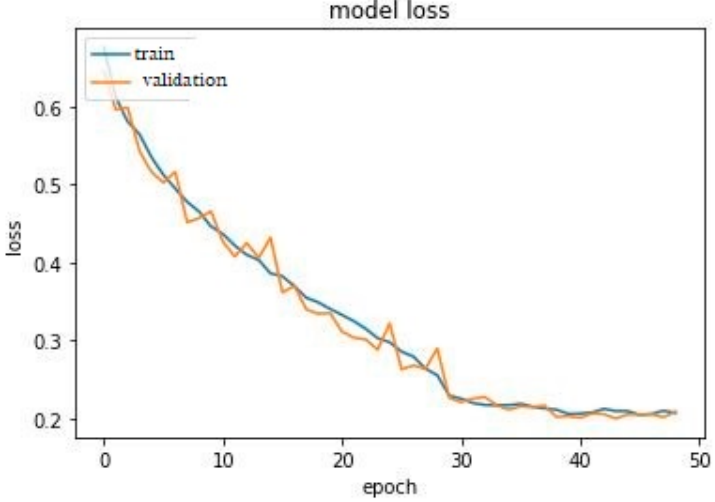
Figure 4. The learning curve for training and validation accuracy.